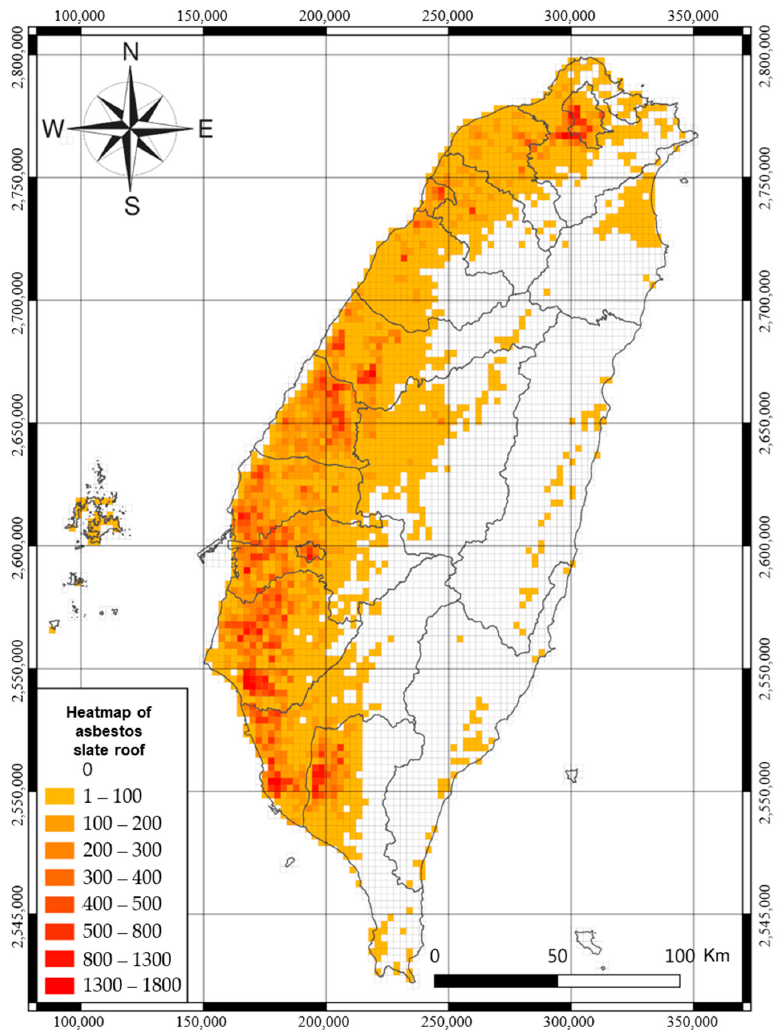
Figure 10. Locations and quantities of detected asbestos-cement corrugated roofing tiles in